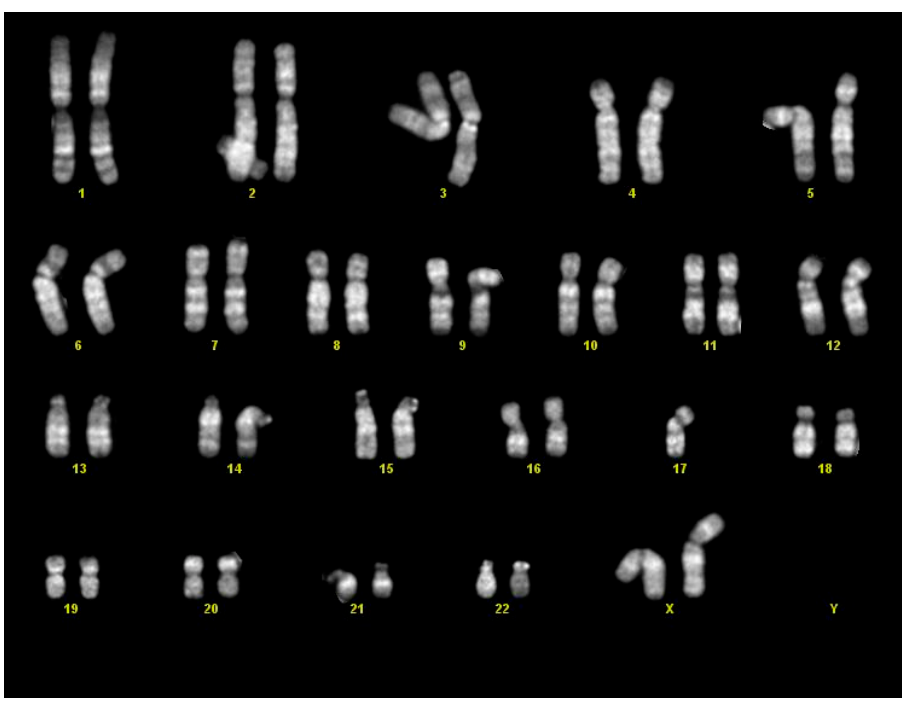
Figure 5. Immature elements of the tumor: neuroectodermal structures with ependymal rosettes (HE staining 20×).